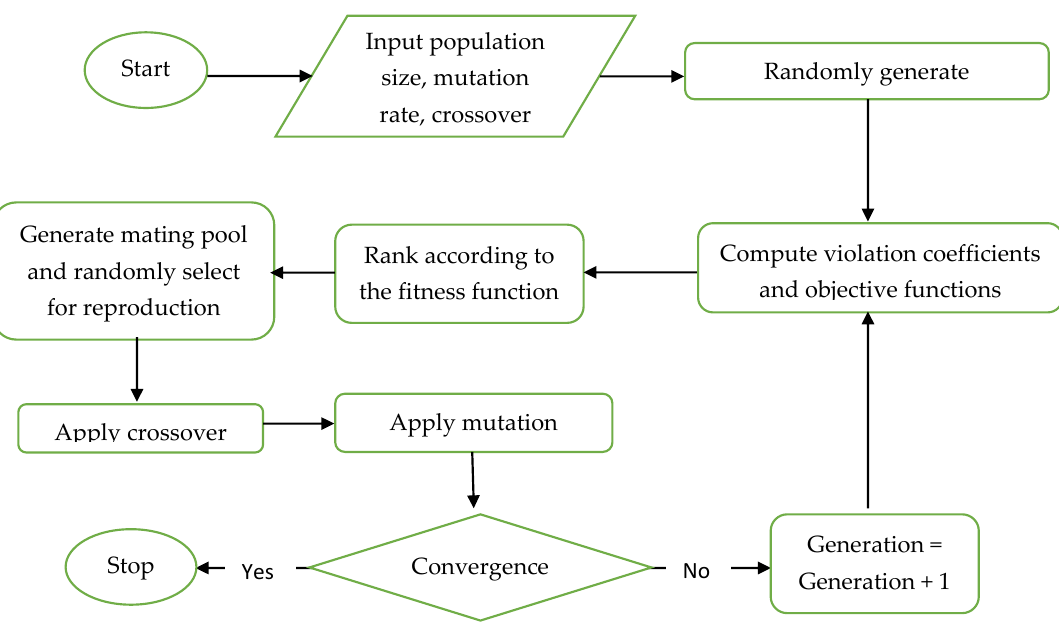
Figure 3. Flow chart showing the steps involved in evolutionary algorithm.